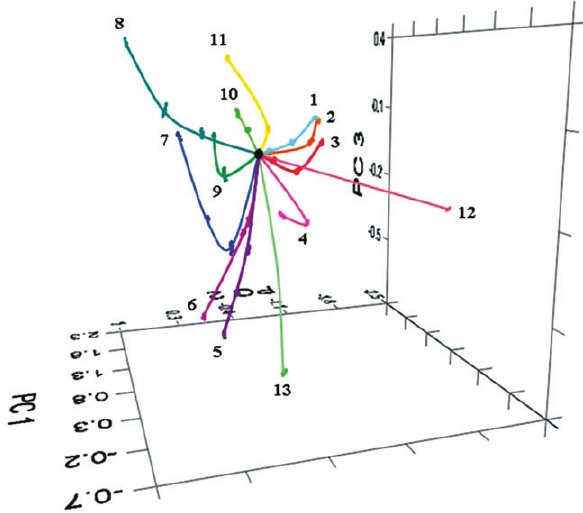
Figure 10 Three-dimensional PCA plot of MC sensor array response to 13 gaseous analytes. Reproduced with permission from Loui et al. (2008)